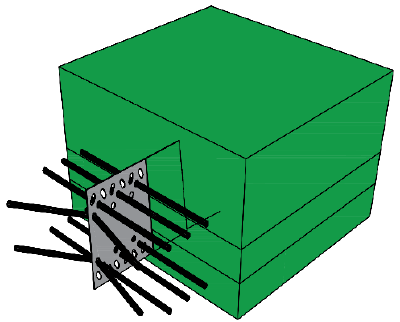
Figure 10. Model drawing of plate-type shear connector.